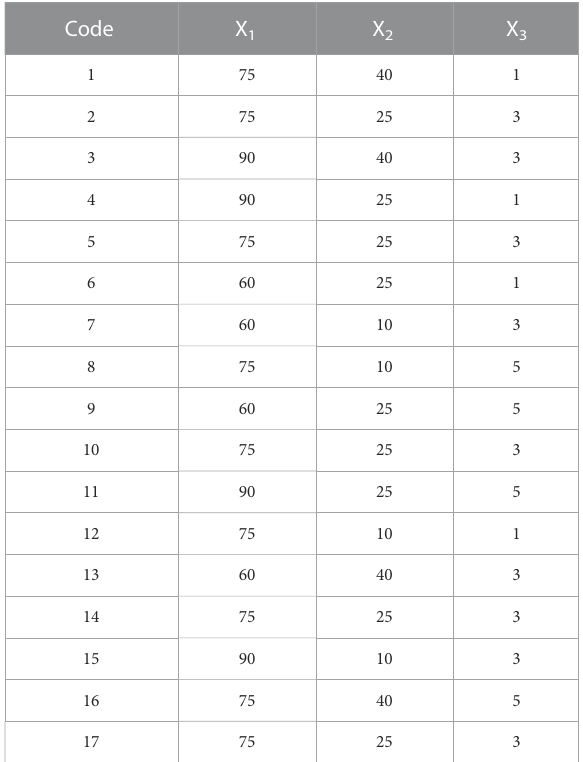
TABLE 6 Experiment design table. TABLE 7 Orthogonal experimental design